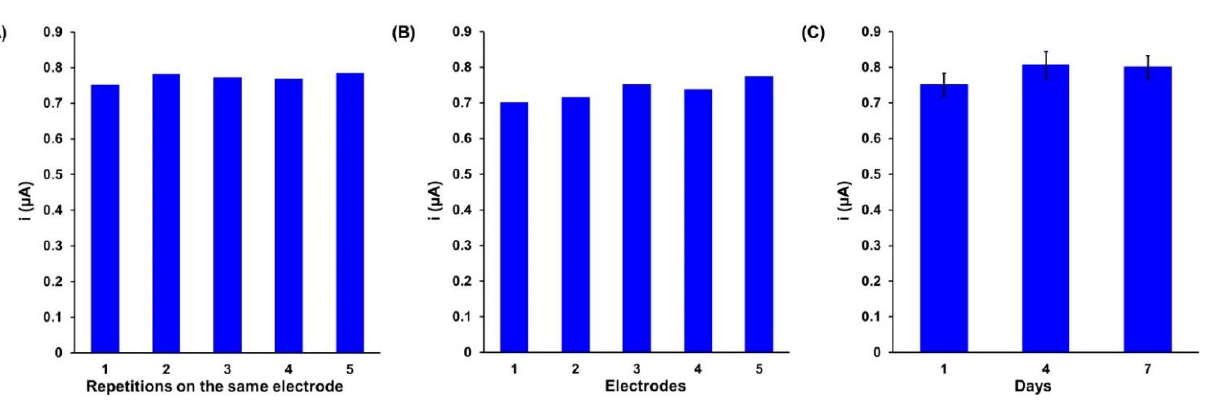
Figure 3. Results of ( A ) repeatability, ( B ) reproducibility, and ( C ) stability studies obtained for the gold electrodes modified with Au-S-Apt-Fc/MCH.